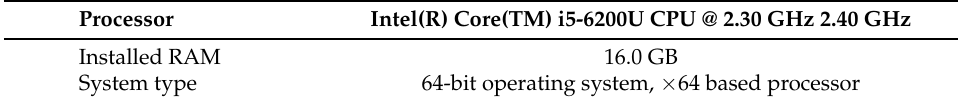
Table A3. Hardware specifications.